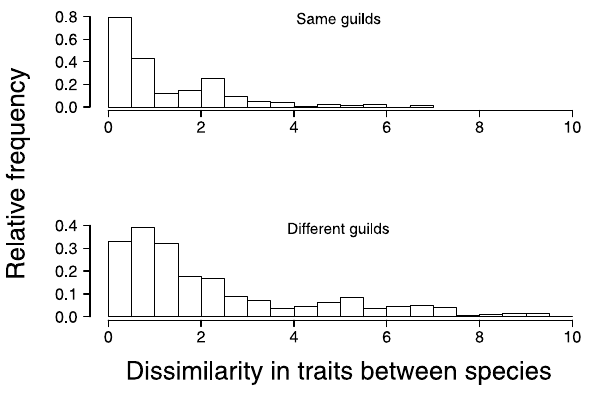
Figure 1. Dissimilarity in morphological traits between species of same foraging guild (upper panel) and between species of different foraging guilds (lower panel).